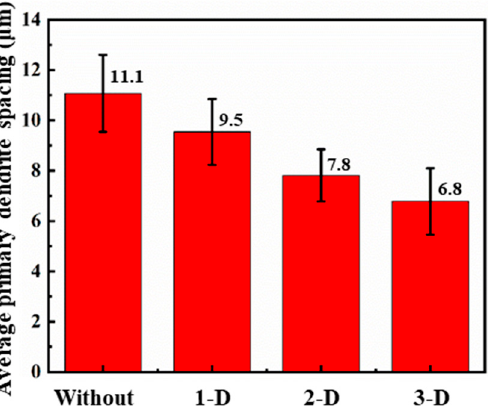
Figure 6. Comparison of average primary dendrite spacing in the middle of cladding layer with and without vibration.